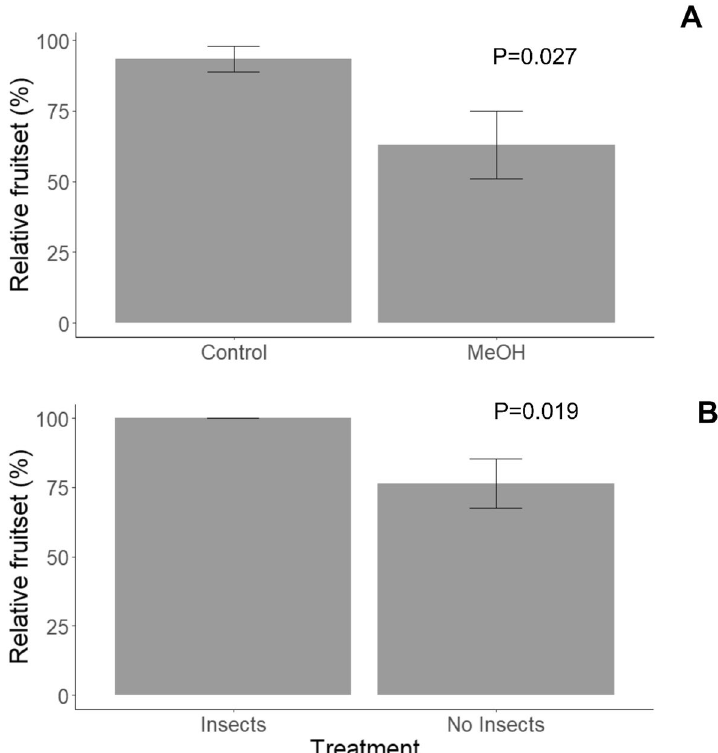
Figure 5. Mean relative fruit set (± SE) of sticky flowers of ( A ) Bejaria resinosa washed with 100 μL of 95% methanol (MeOH) or adding methanol to the pedicel (Control) and ( B ) of Bejaria resinosa flowers with two different treatments. No Insects treatment, the insects stuck in these flowers were removed manually. Insects treatment, the insects that were removed from the No Insect treatment were added to this